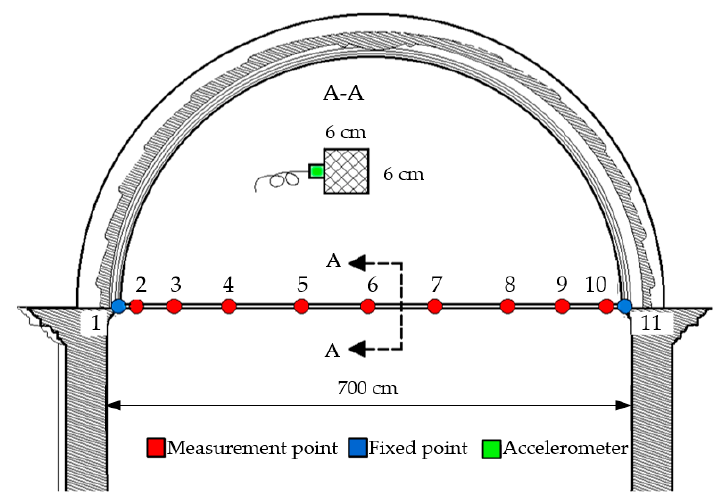
Figure 8. Reference tie rod (6B-C, R4) with measuring points and dimensions.